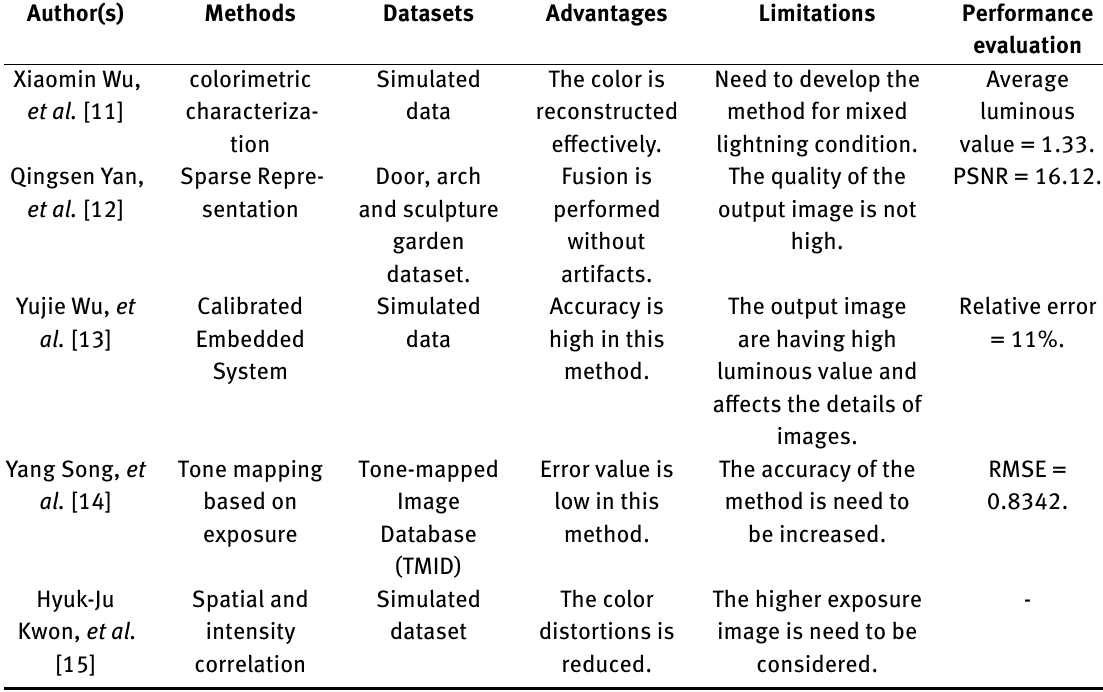
Table 1: Comparisons of previous studies